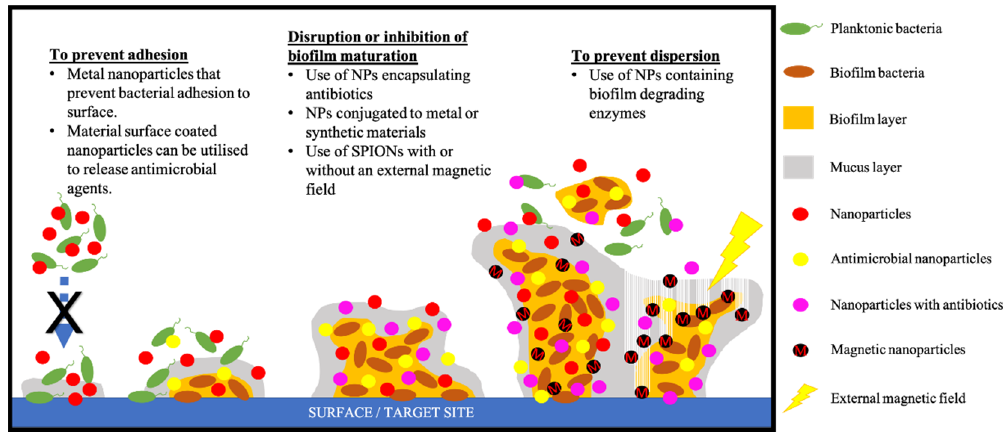
Figure 3. Nanoparticle-based strategies that can be used to target each stage of biofilm bacteria development.